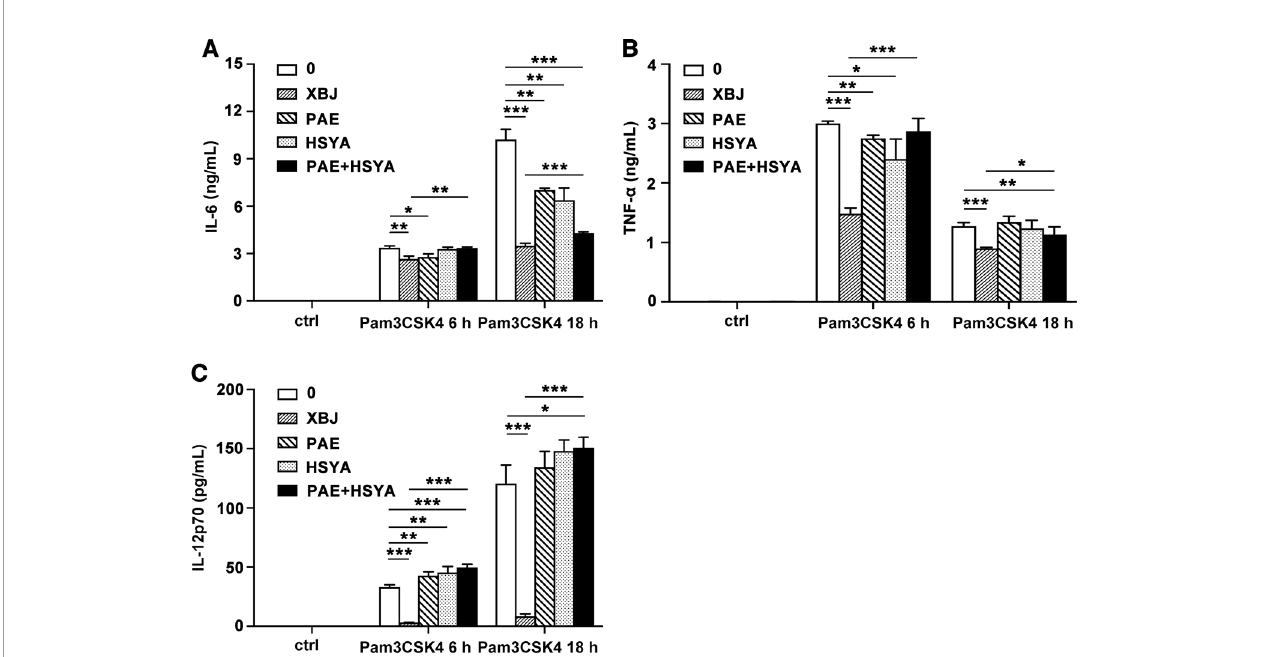
FIGURE 10 | Comparison of anti-in fl ammatory effects of XBJ and its main components. Mouse primary peritoneal macrophages were seeded at 3.5 × 10 5 cells/well in 24-well plates and cultured overnight. Cell were treated with XBJ (10 µl/ml), PAE (26.7 µg/ml), and HSYA (13.7 µg/ml) with or without Pam3CSK4 (100 ng/ml) for 3, 6, or 18 hours. The concentrations of IL-6 (A) , TNF- a (B) , and IL-12p70 (C) in the cell culture supernatant were detected by ELISA. Data were shown as mean ± SD (n=3). * , ** , ***Signi fi cantly different at p < 0.05, p < 0.01, and p < 0.001,